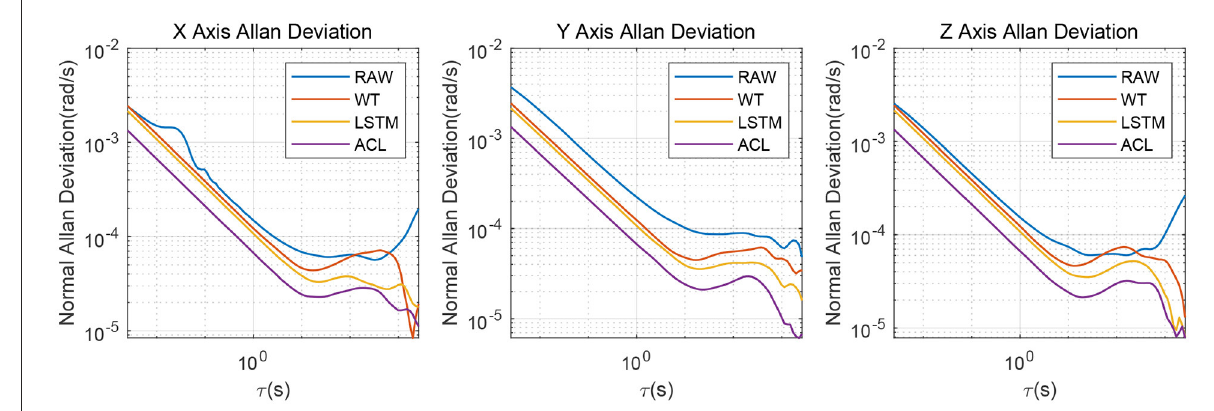
FIGURE8 Allan variance comparison between denoised and raw signals for the 3-axis gyroscope of XSENS MTI-G-700.